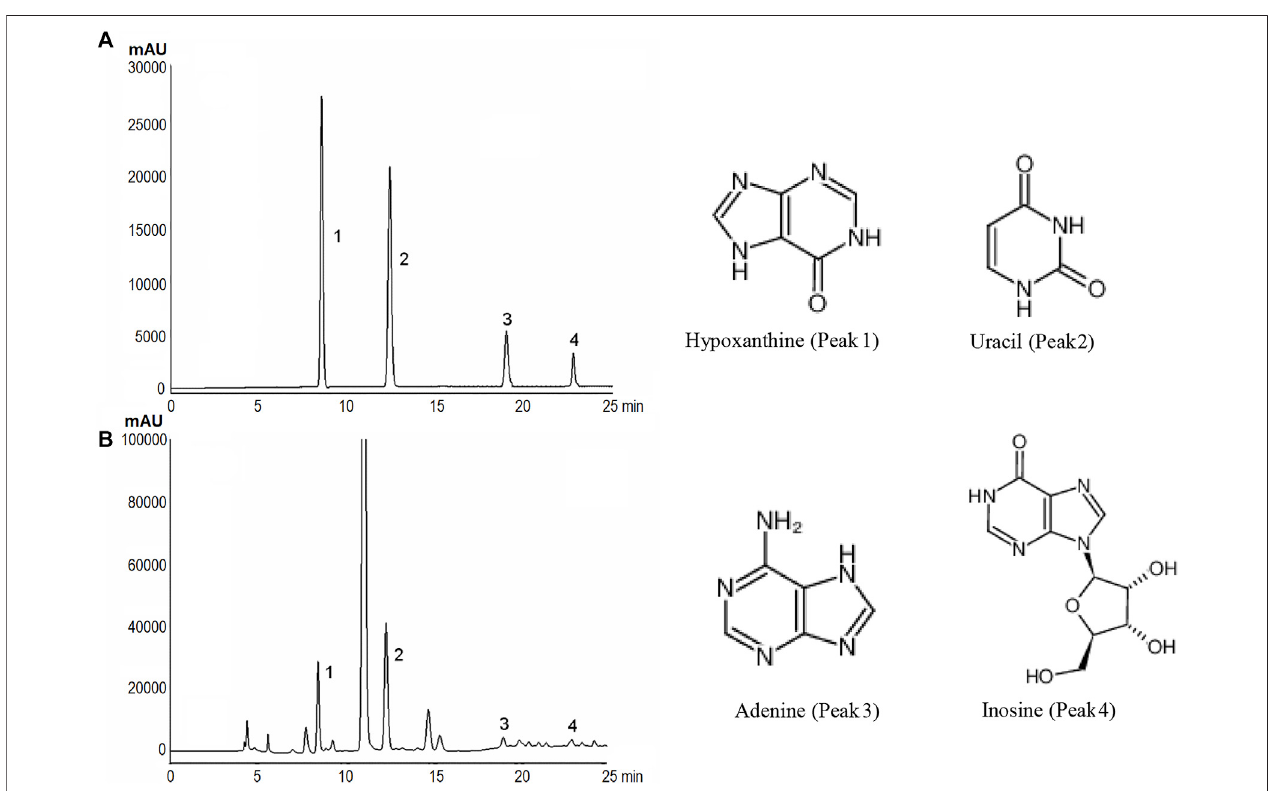
FIGURE 2 | HPLC spectra and chemical structures of these representative markers of PAE obtained with 20% ethanol extraction. (A, B) represented the chromatogarm of four representative markers and PAE.